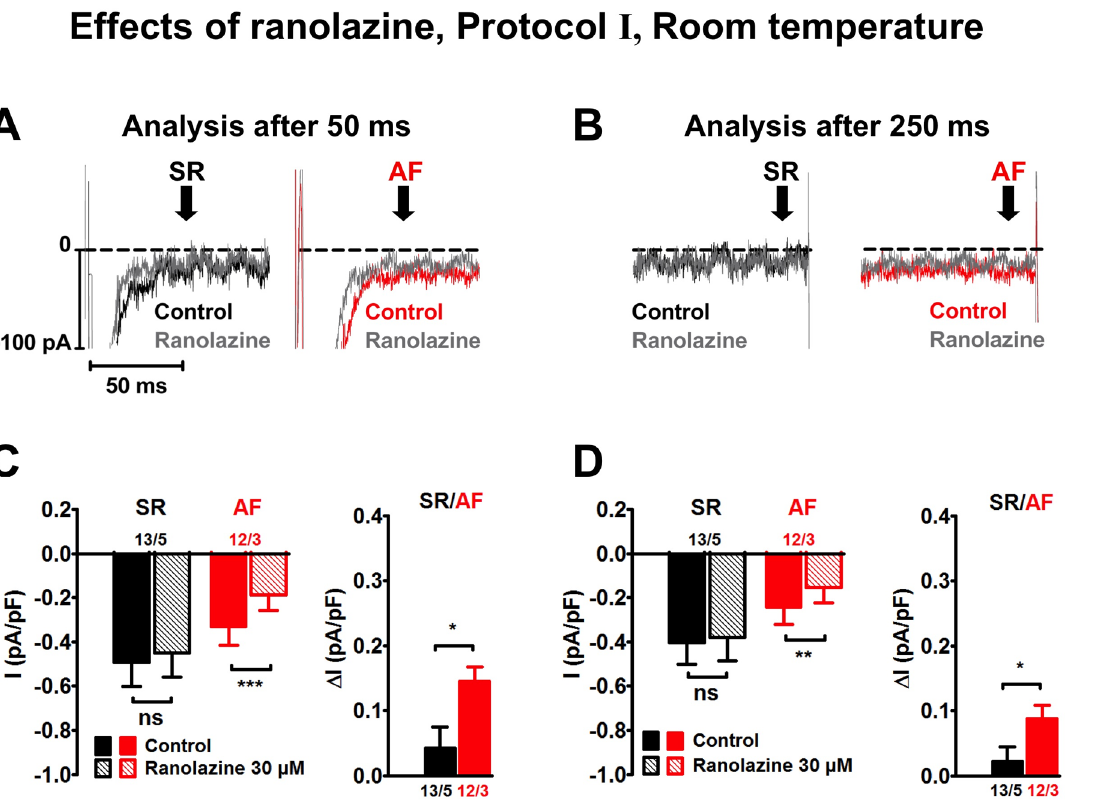
Fig 4. Effects of ranolazine on I Na,late measured with protocol I in human atrial myocytes at room temperature. Similar lay-out as in Fig 3.